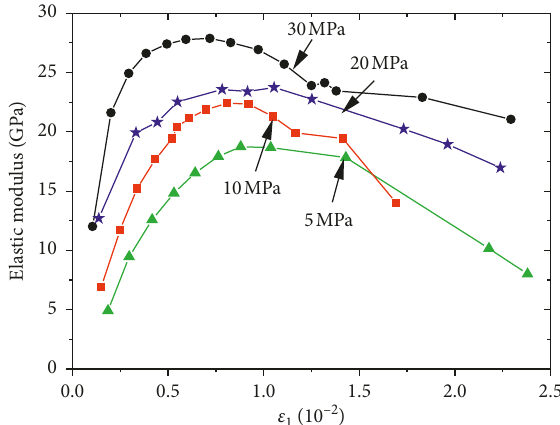
Figure 7: Elastic modulus-strain curves during cyclic loading-